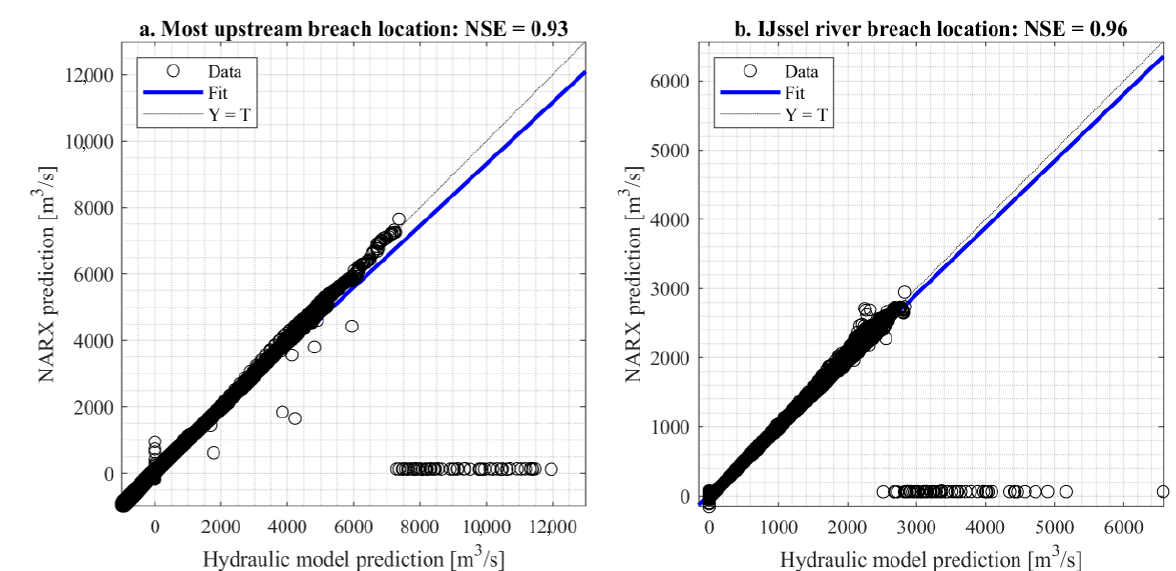
Figure 7. Regression lines for the two potential dike breach locations where the blue line represents the 1:1 linear fit and the Y = T line the fitted linear line based on the training data produced with the hydraulic model (T) and NARX predictions (Y).